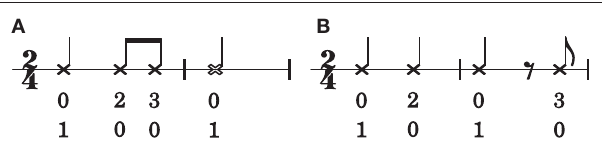
FIGURE 5 | Two rhythms that result in different orderings of the same set of mp ⊗ bd viewpoint elements. The number-pairs below the notes are the values of mp ⊗ bd . The top number represents the value of the bd (bar-distance) viewpoint, the bottom number represents the value of the mp (metrical position; expressed in multiples of an eighth note duration) viewpoint. The rhythm in (A) is structurally different from the rhythm in (B) , but under a zeroth-order mp ⊗ bd viewpoint, they are